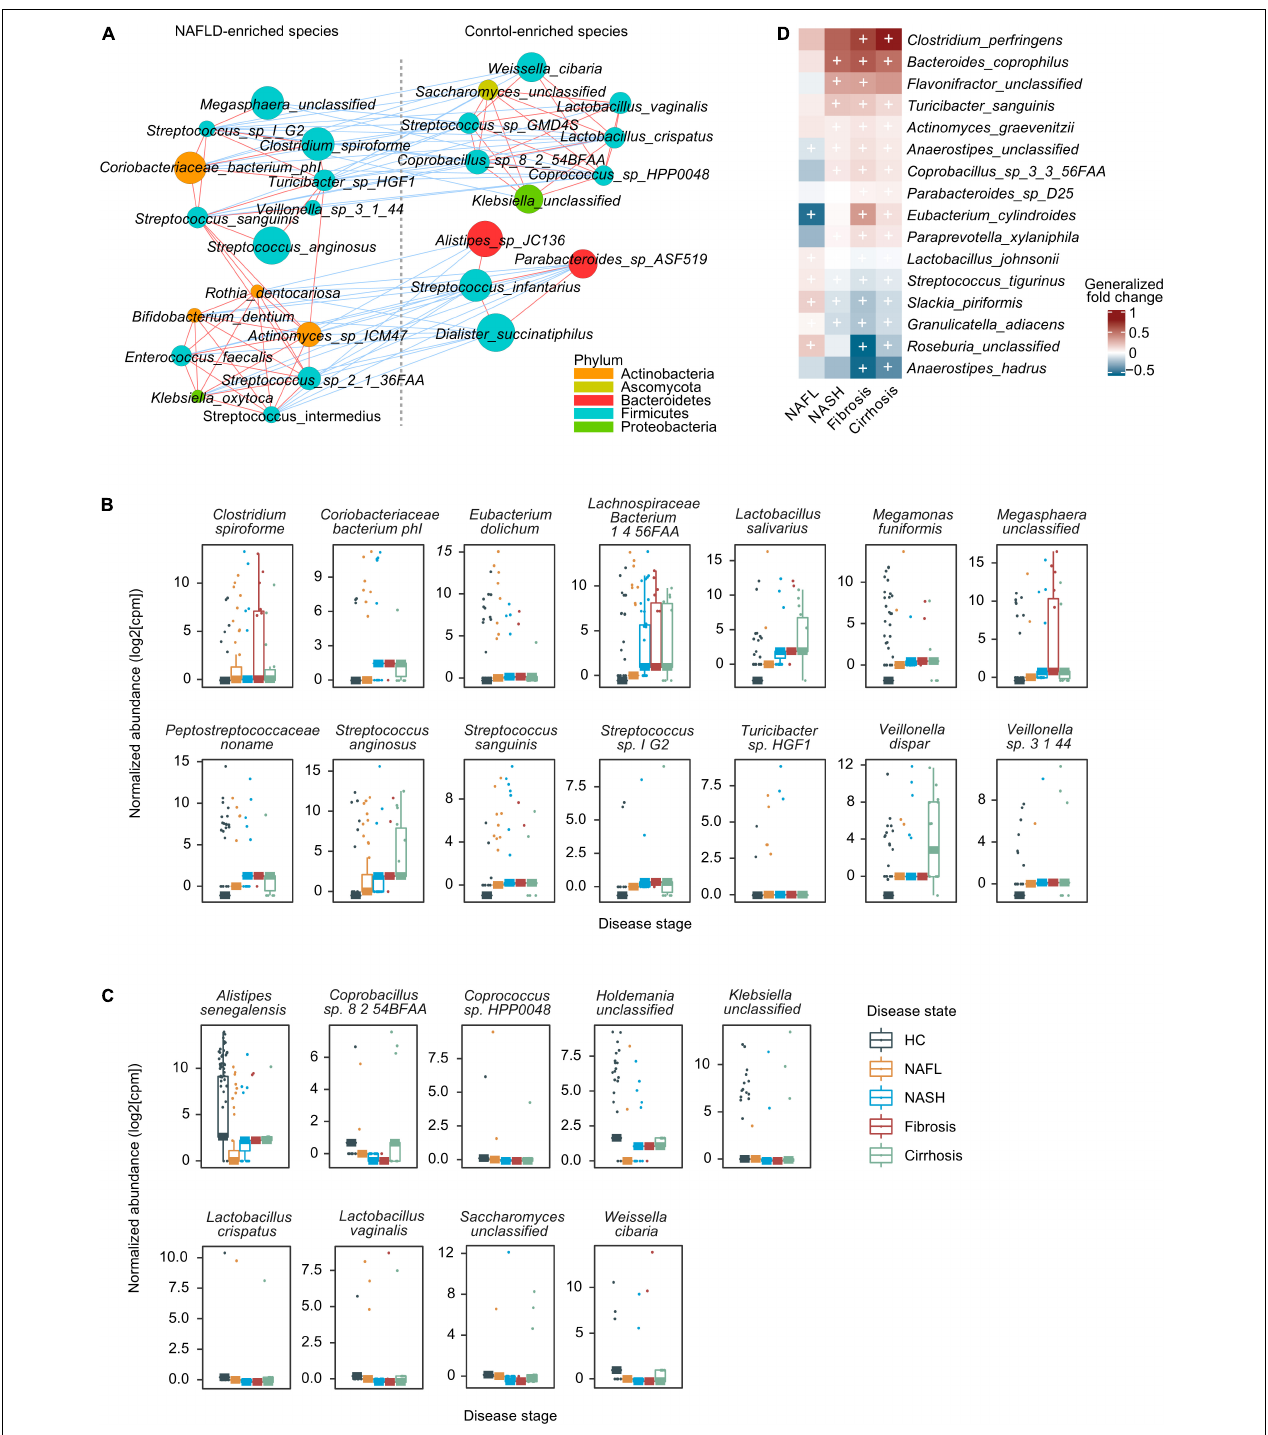
FIGURE 3 | A co-occurrence network and the correlation between gut microbes and NAFLD. (A) A co-occurrence network for the core set of highly significant species. The size of the nodes indicates normalized abundance. The color of the nodes indicates their taxonomic assignment. Connecting lines represent Spearman correlation coefficient values above 0.8 (red) or below − 0.8 (blue). (B) Boxplots showing that species was significantly correlated with NAFLD stages using partial Spearman’s rank-based correlation (pSRC), adjusted for BMI (two-sided, FDR < 0.05). (C) Boxplots showing that species was significantly anti-correlated with NAFLD stages (pSRC, two-sided, FDR < 0.05). (D) Heatmap showing the species that significantly and consistently changed in the last three stages (blocked two-sided Wilcoxon tests, + indicates statistical significance FDR < 0.05). Generalized fold change is colored by direction of the effect, where red indicates higher abundance in patients and blue indicates depletion. HC, healthy controls; NAFL, non-alcoholic fatty liver; NASH, non-alcoholic steatohepatitis.